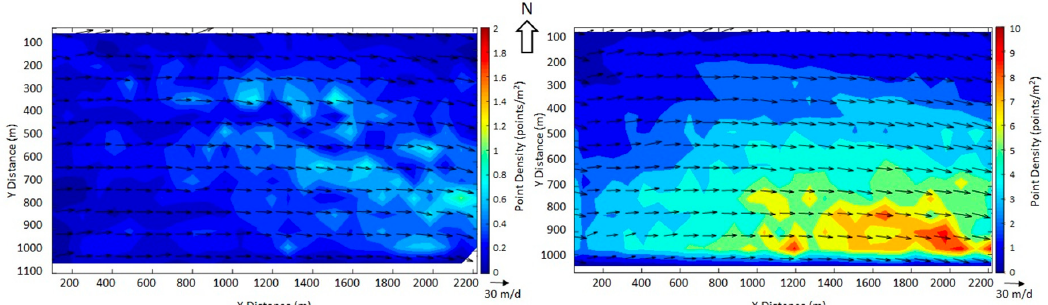
Figure 7. Region 1 results on the left and Region 2 results on the right, both for a time interval of 51 minutes. The Helheim Glacier PIV results have been plotted on top of a contour plot of point density, rather than roughness. It is important to note that point density is scaled differently for Regions 1 and 2, in order to highlight the attributes of each. Raw PIV results were averaged at a resolution of 100 m × 100 m. Though not shown, average surface roughnesses for Regions 1 and 2 were 0.8 m and 1.0 m, respectively.